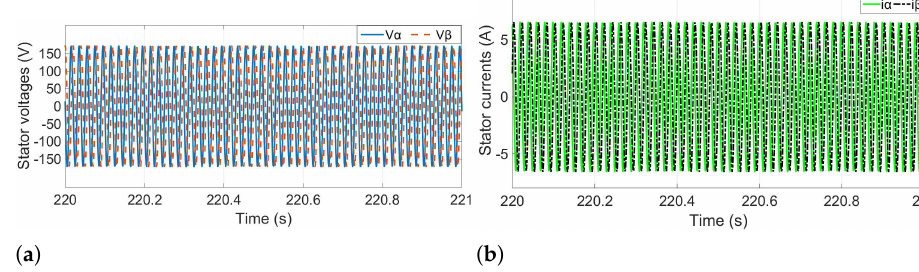
Figure 6. SMC-based EV powertrain ( a ) Voltages ( b ) Currents.